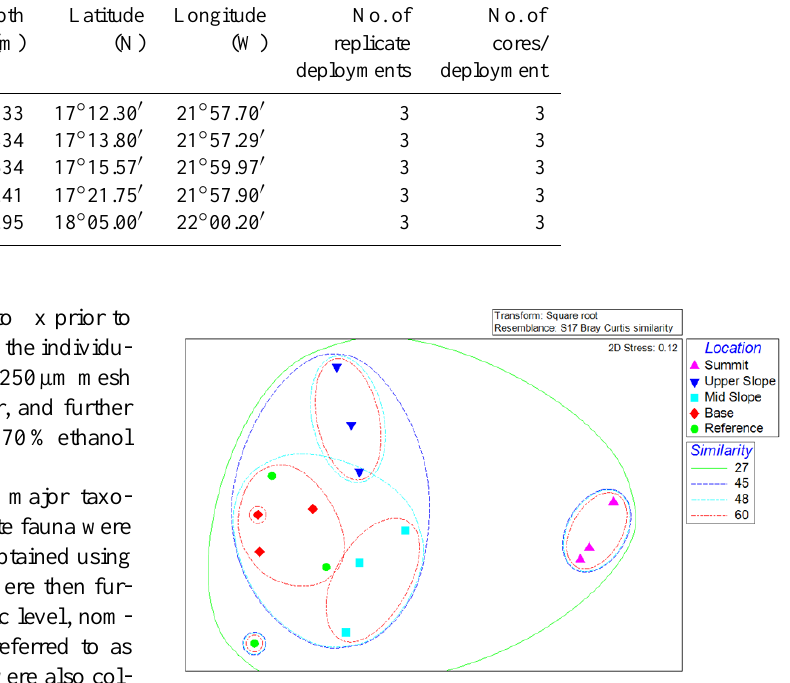
Fig. 2. Non-metric multi-dimensional scaling (MDS) ordination of the polychaete families along the northern transect on Senghor Seamount (27, 45, 48, and 60% similarity levels defined by cluster